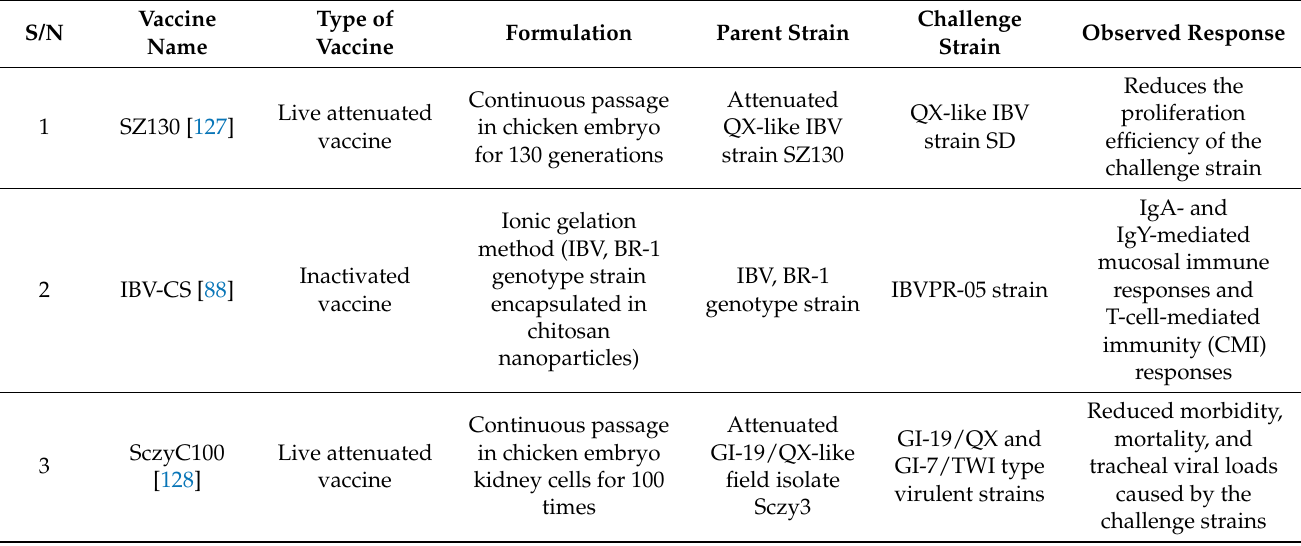
Table 1. Available vaccines against infectious bronchitis in